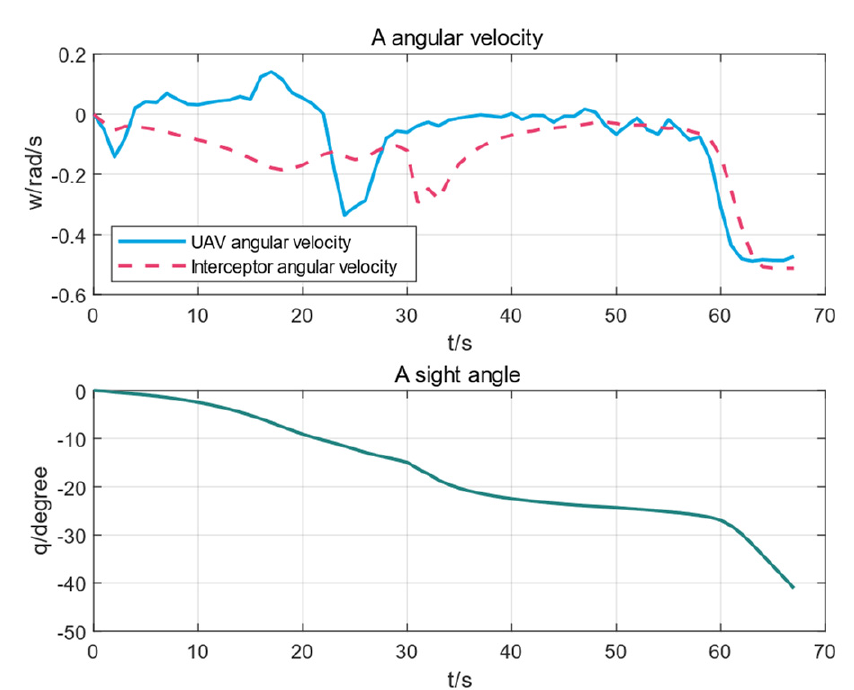
Figure 8. The parameter change curve of UAV A and Interceptor A during training.